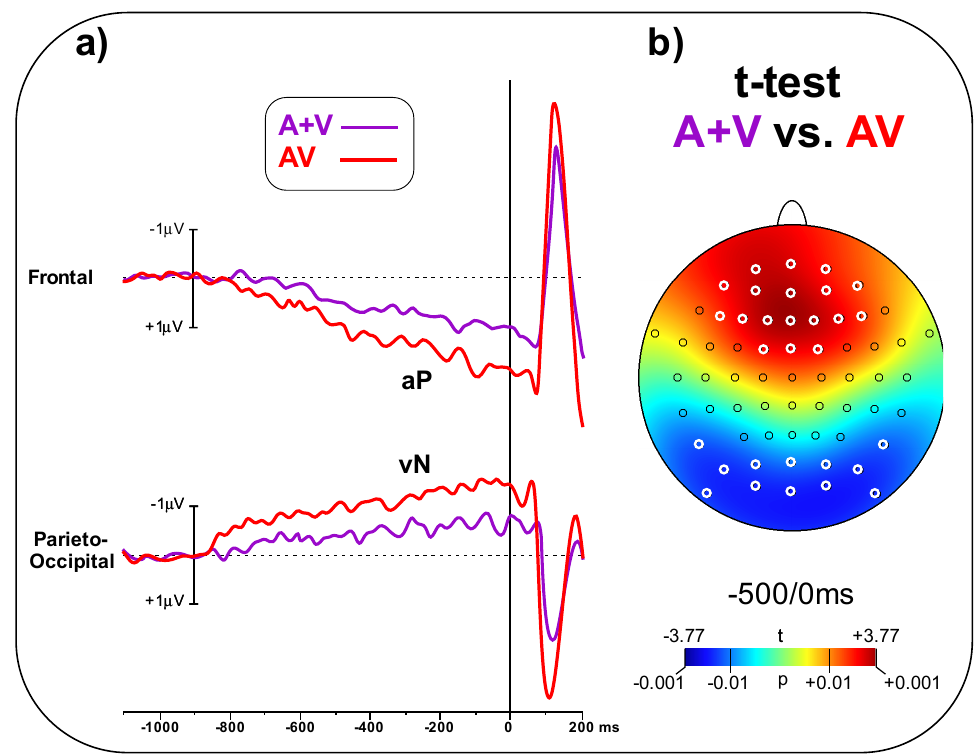
Figure 4. ( a ) Simultaneous (AV) and summed (A + V) pre-stimulus ERPs can be observed in the two electrode pools. ( b ) Statistical map depicting the t-test topographical distribution. Electrode scoring (t < 0.01) is highlighted in white.